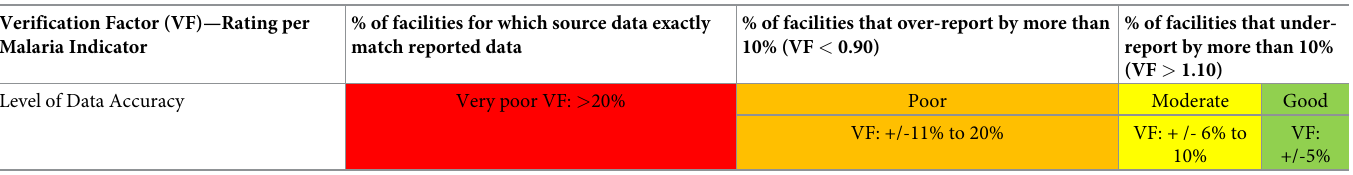
Table 2. Accuracy key. Verification Factor (VF)—Rating per Malaria Indicator